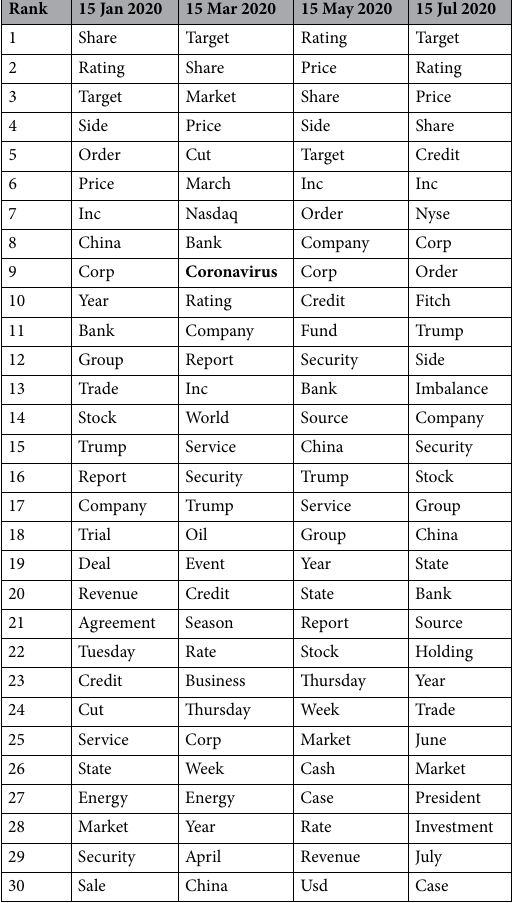
Table 1. Top 30 most salient words for the fifteenth day of January, March, May, and July 2020. The term coronavirus is the most salient term only on 15 March